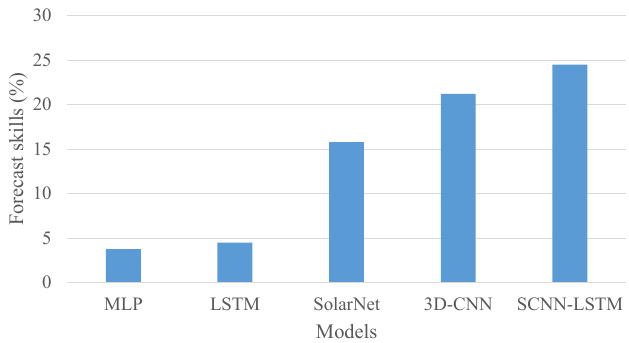
Figure 8. Forecast skills of the five last models in Table 4 compared to the persistent model.